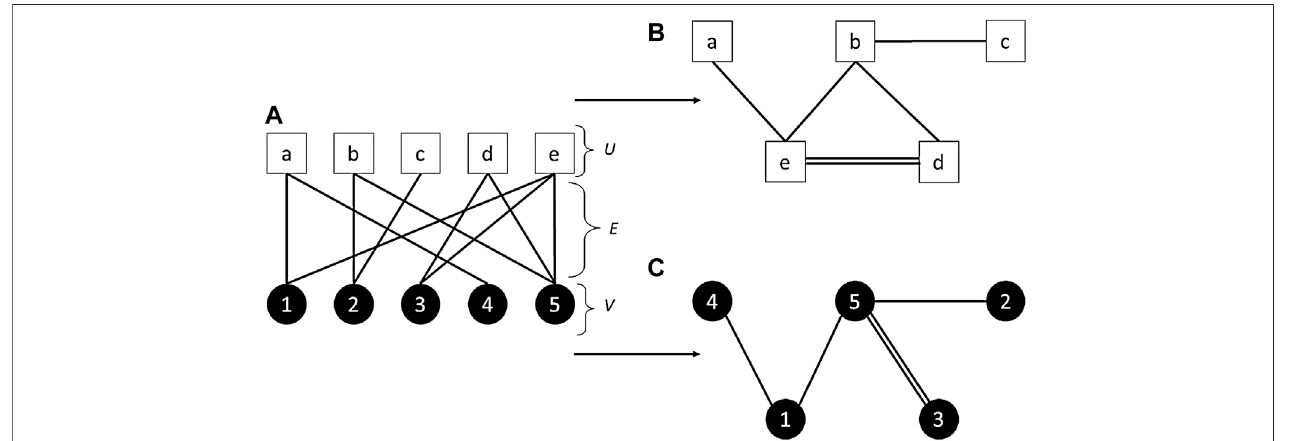
FIGURE4| AnExampleofaBipartiteNetworkanditsProjections.Inthecaseofthecurrentstudy,whitenodes(set U )representstandards,andblacknodes(set V ) representstudents. (A) Nodesofdifferentsetsareconnectedbyanedge E (i.e.,anedgewillexistifastudenttookaparticularstandard). (B) Theprojectionofset U .Inthe current study, we use this projection to represent a network of standards. Two standards will be connected by edge if a student enrolled in both standards. If two standards are connected through multiple students, multiple edges are produced. In this simple example, two students enrolled in both standards e and d , while other connected standards were only take conjointly by single students. (C) The projection of set V . In the current study, this refers to a network of students, with edges indicating that students both took the same standards. To help preserve students ’ con fi dentiality, we do not report on this projection.